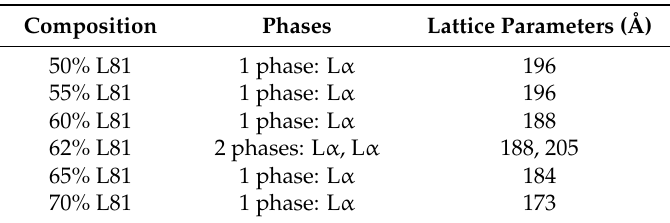
Figure 9. Phase diagram of Pluronic L81/water/MEA + CO 2 .